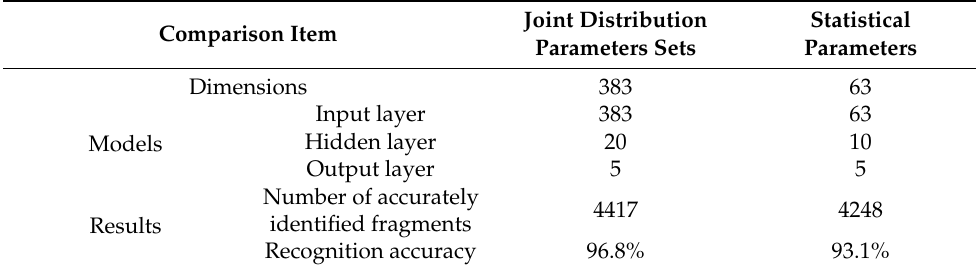
Table 3. Comparison of models and